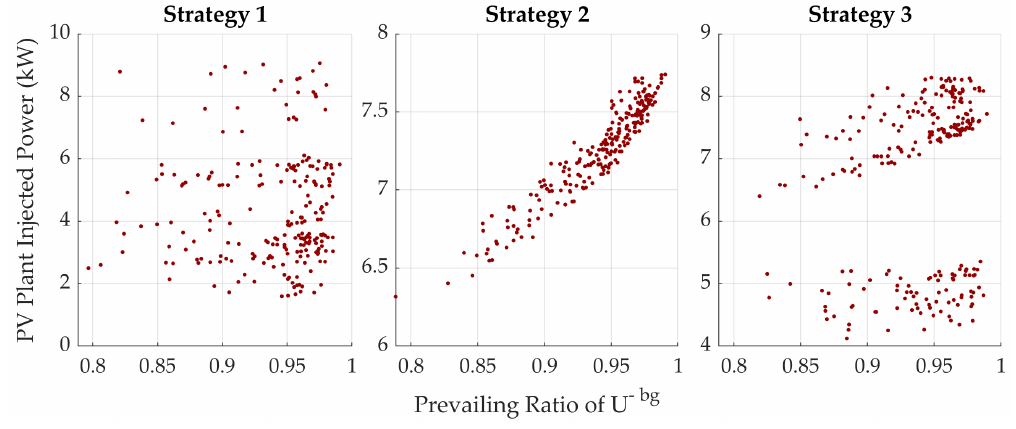
Figure 11. Maximum PV injection at different PR values of background VU.